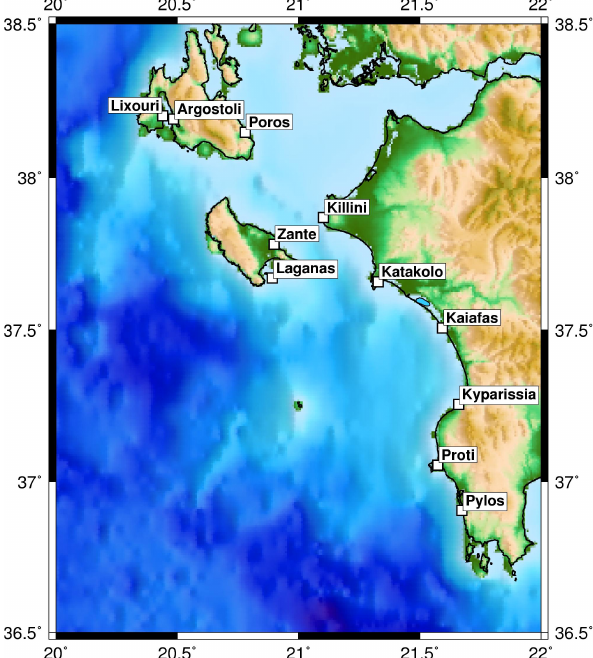
Fig. 4. Locations of the gouges considered in the present investi- gation, which represent the most populated tourist resorts along the Ionian shoreline.